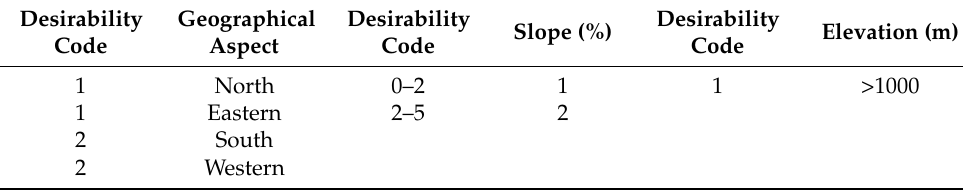
Table 2. Classification and coding of factors of elevation, slope, and geographical aspect.